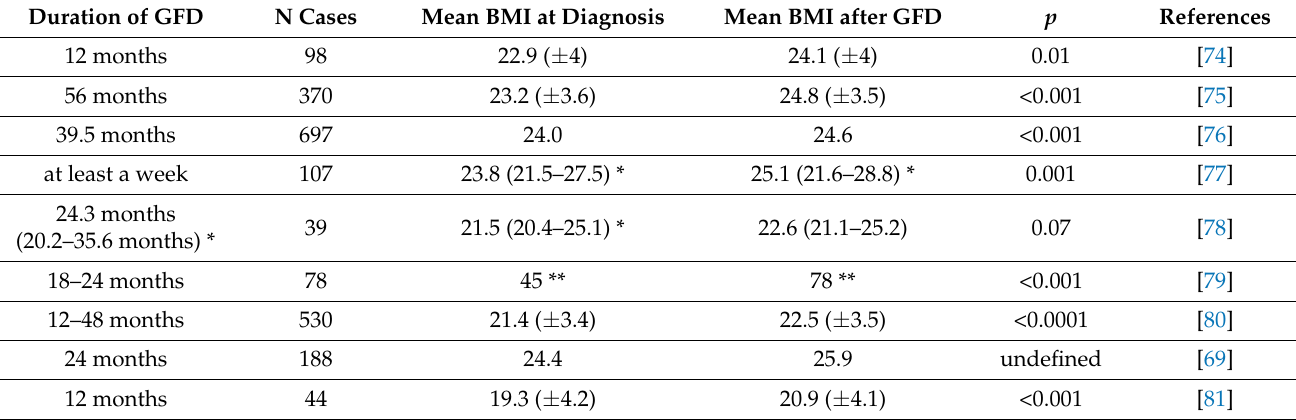
BMI: Body Mass Index, GTD: Gluten-free diet *, median, ** patients with BMI >